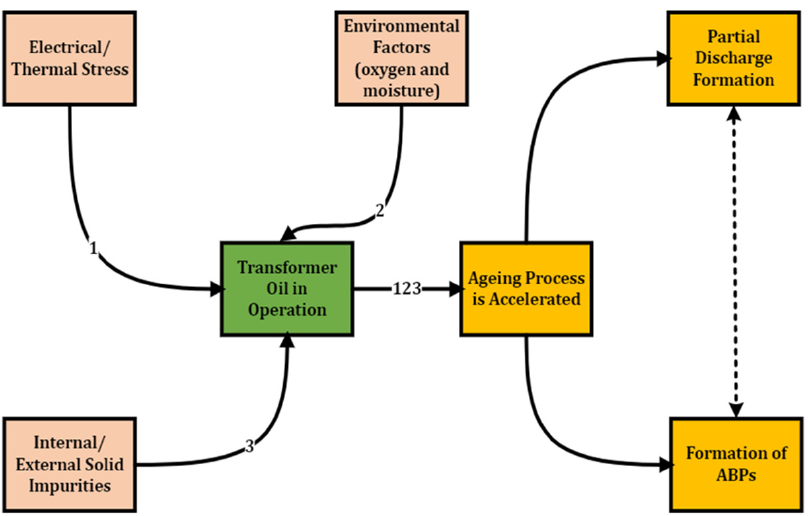
Figure 1. Degradation Mechanism of Transformer Oil .